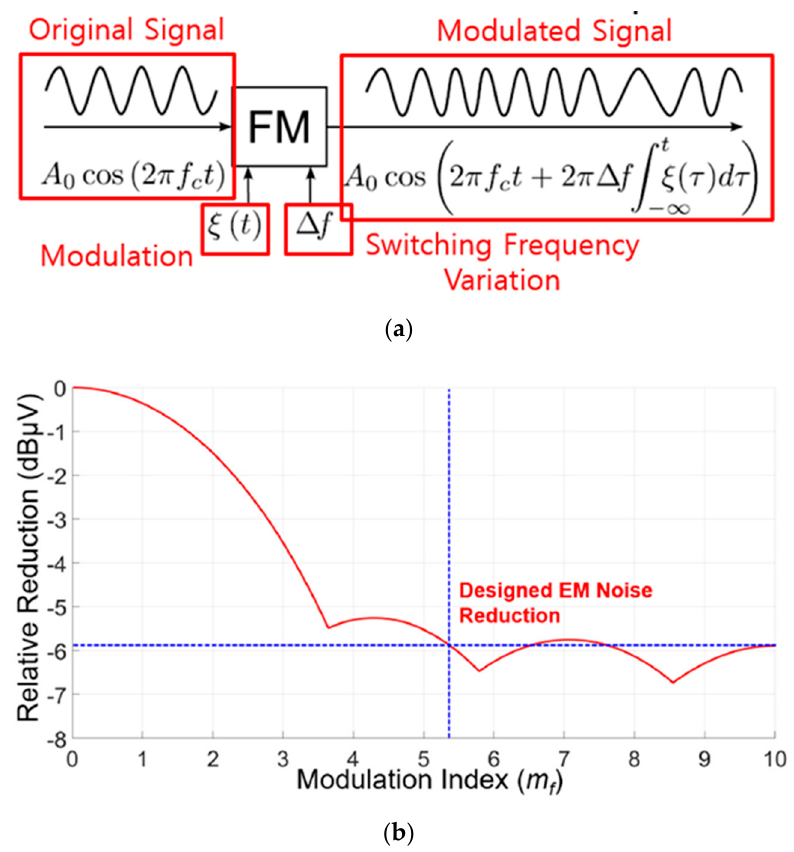
Figure 16. Spread spectrum technique and electromagnetic interference (EMI) reduction: ( a ) operational principle of spread spectrum technique (SST), and ( b ) relative EM noise reduction by SST.